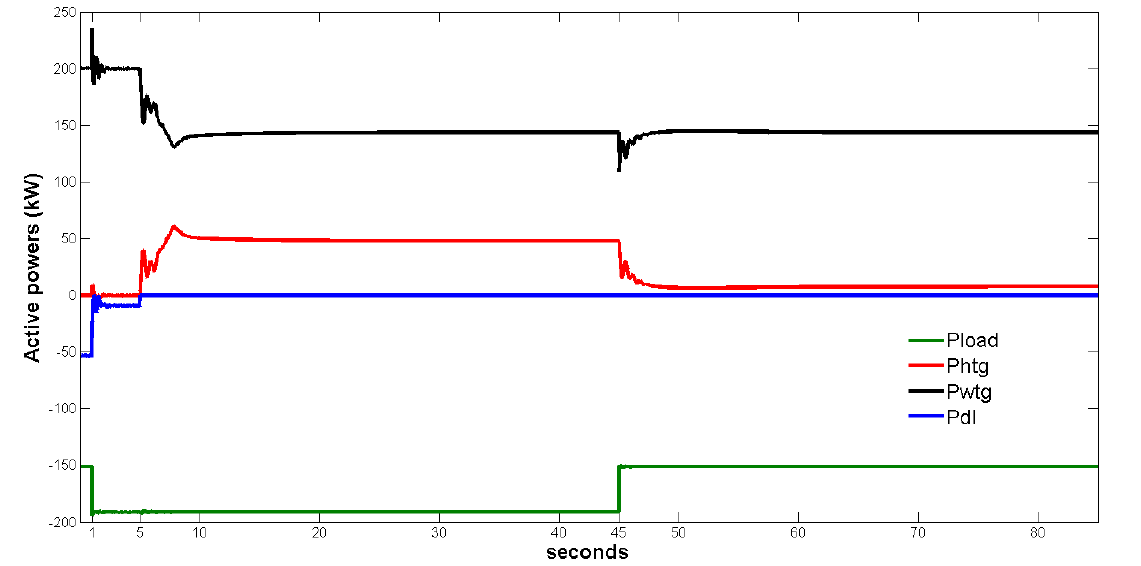
Figure 10. Active powers in WTG, HTG, consumer load and dump load in